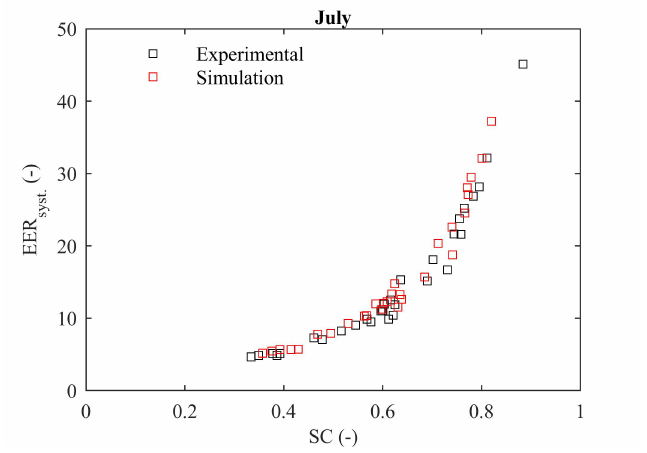
Figure 7. Comparison between experimental and predicted daily values. EER vs. SC curve.